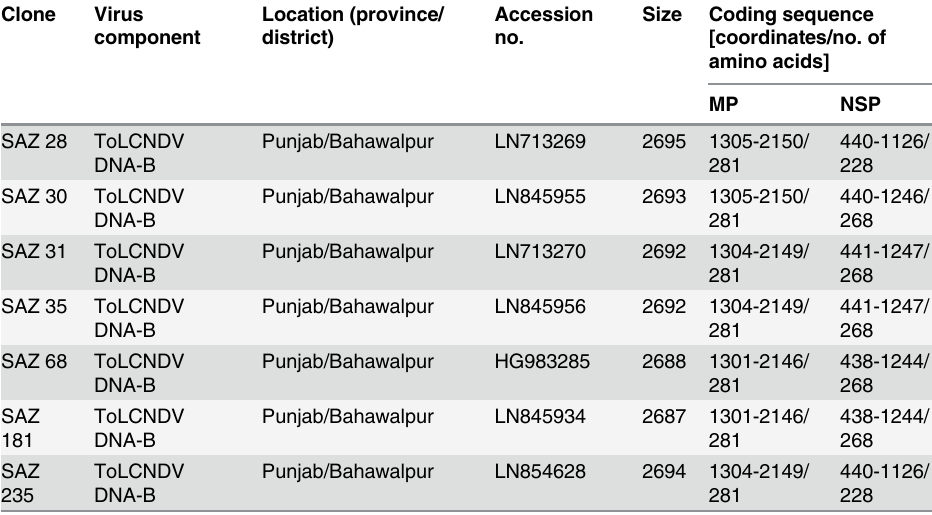
Table 3. Origins and features of bipartite begomovirus DNA-B component clones